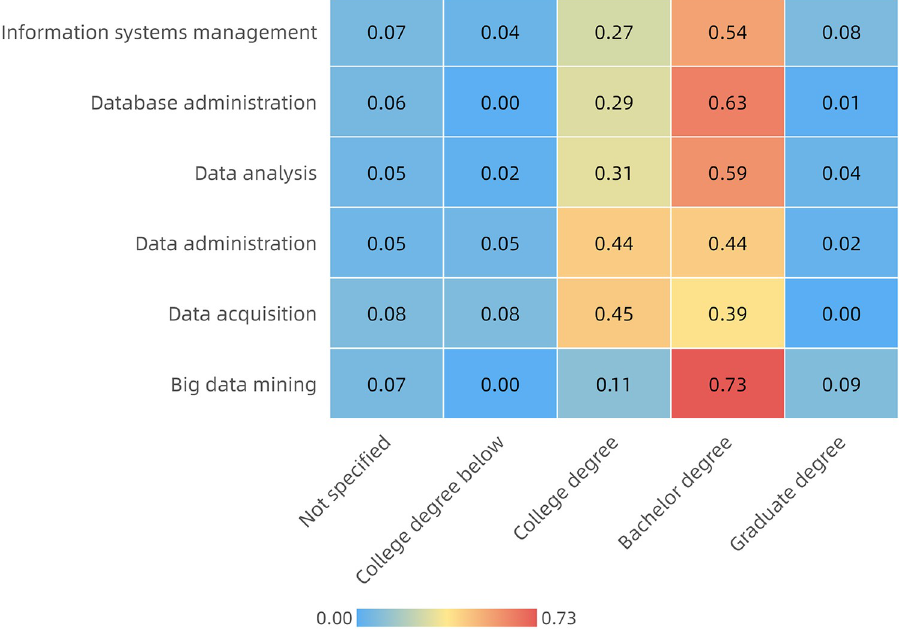
Fig 8. Proportion of educational degrees in each